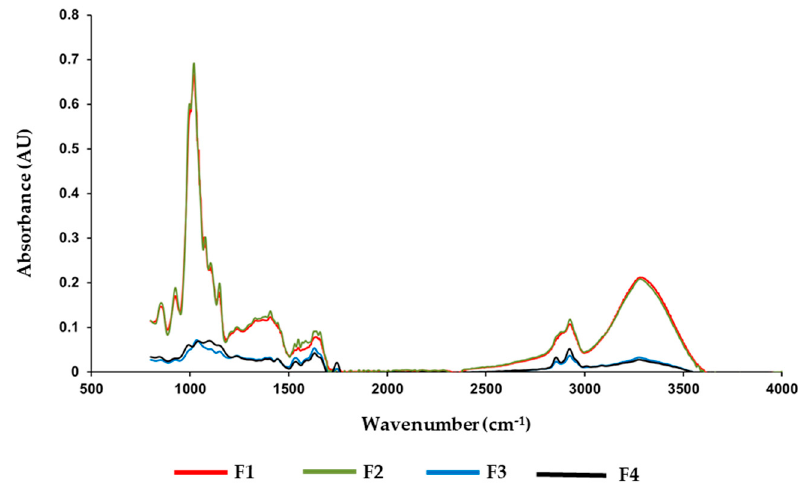
Figure 1. FTIR spectra of chickpea flour films. F1: 3% glycerol, pH 7; F2: 3% glycerol, pH 10; F3: 1% glycerol, pH 7; F4: 1% glycerol, pH 10.